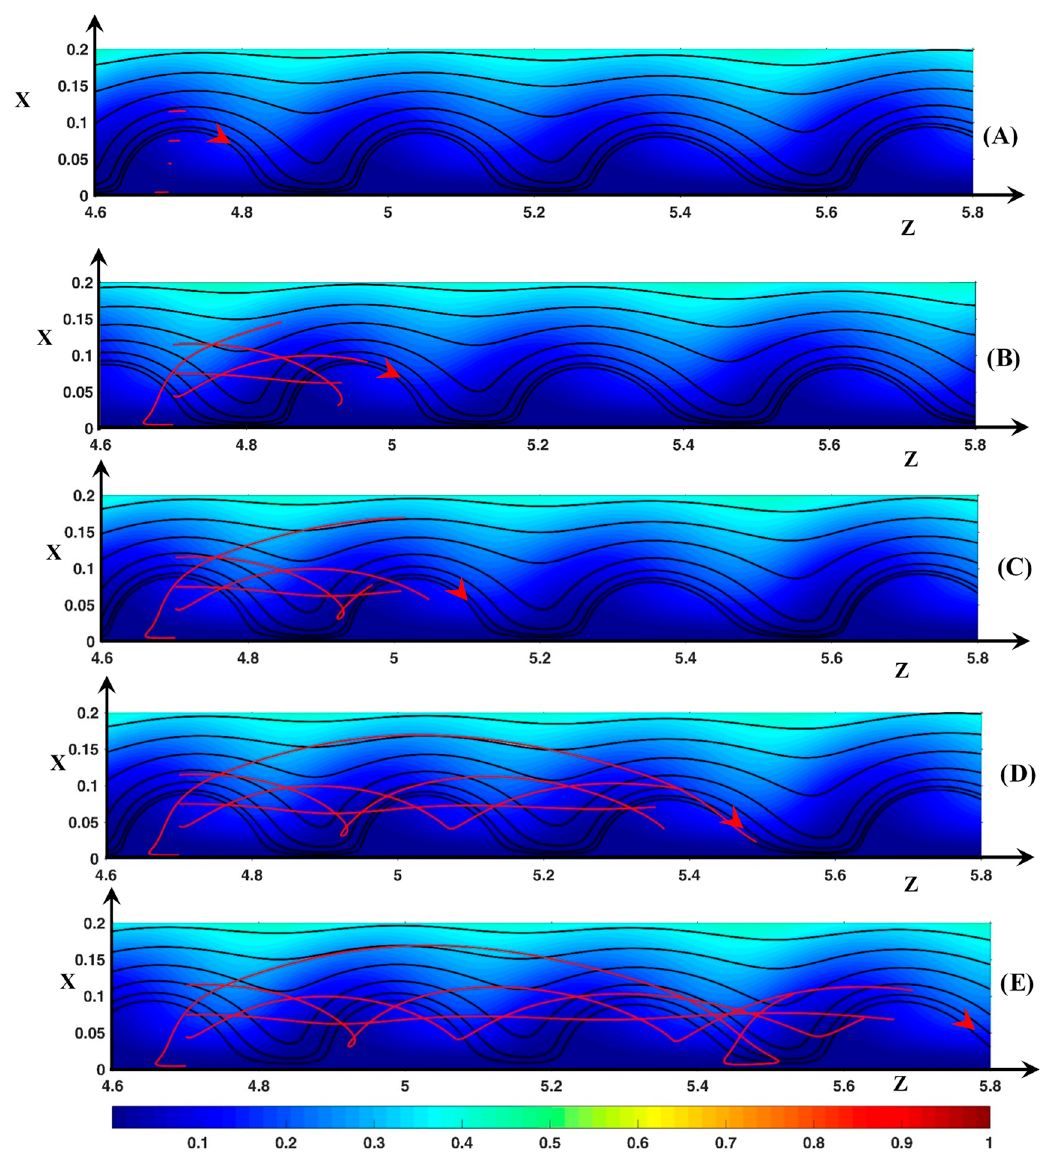
Figure 10. Fluid trajectories. Black lines: static streamlines starting from the inlet. Red lines: dynamic streamlines starting from z o = 4.7 ( x o = 0.005, 0.045, 0.075, 0.115). Color plot: cation concentration. The red arrow represents the rotation direction of the vortices and the position of the vortex at time t ’ (the trajectories start at t ’ = 0 inside this vortex). ( A ) t ’ = 5; ( B ) t ’ = 70; ( C ) t ’ = 95; ( D ) t ’ = 195; ( E ) t ’ = 275. ΔΦ = 22, ν = 1/3 × 10 − 3 , D ± = 1